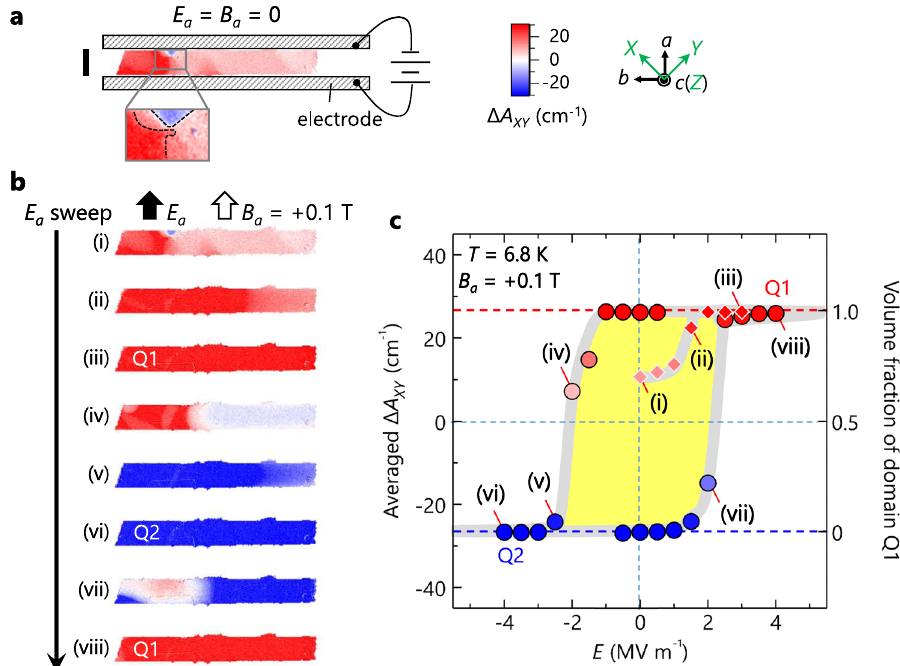
Fig. 6 Optical visualization of isothermal electric- fi eld switching of magnetoelectric quadrupole domains. a Linear dichroism ( Δ A XY ) image of a sample with a narrow electrode gap (100 µ m) taken at 6.8 K after zero- fi eld cooling. Scale bar, 100 μ m. In the magni fi ed view, domain boundaries in the region of the gray box are denoted by the black dashed lines. b Linear dichroism images in a sequentially applied electric fi eld along the a axis ( E a ) in the presence of a bias magnetic fi eld along the a axis ( B a = + 0.1 T). Note that more red (blue) color of the images means a larger fraction of domain Q1 (Q2). c The E a dependence of the linear dichroism averaged over the entire sample area (left axis) and a volume fraction of domain Q1 (right axis). The square and circle symbols represent the virgin curve and the subsequent hysteresis curve, respectively. The Roman numerals correspond to the images in b . The hysteresis with a clear saturation con fi rms a complete electric- fi eld switching of quadrupole